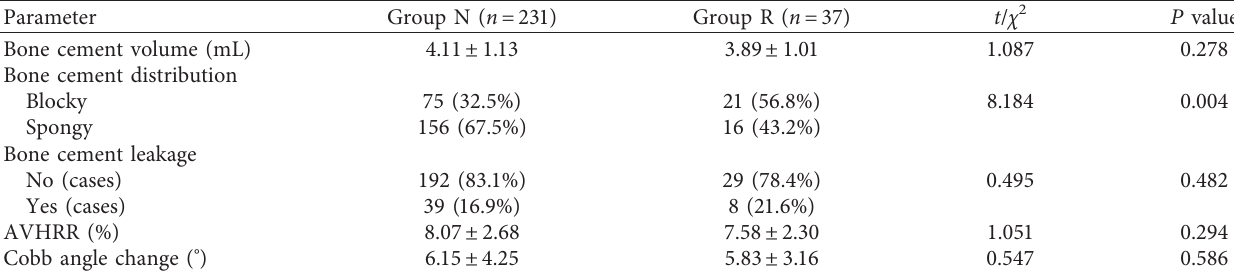
Table 4: Comparisons of postoperative radiological parameters between patients between group N and group